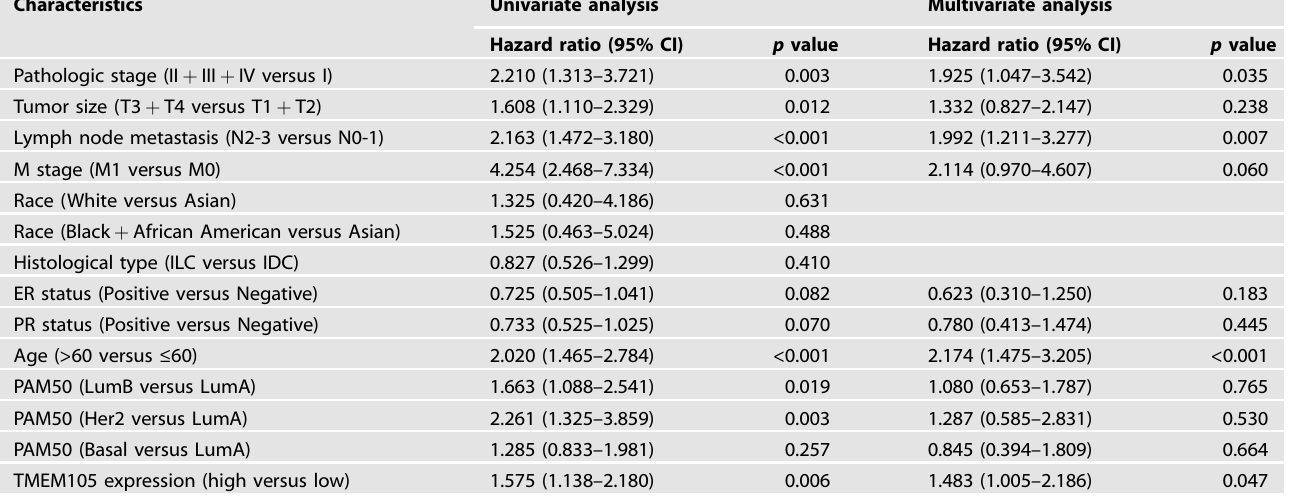
Table 1. Univariate and multivariate Cox regression analyses of overall survival in breast cancer